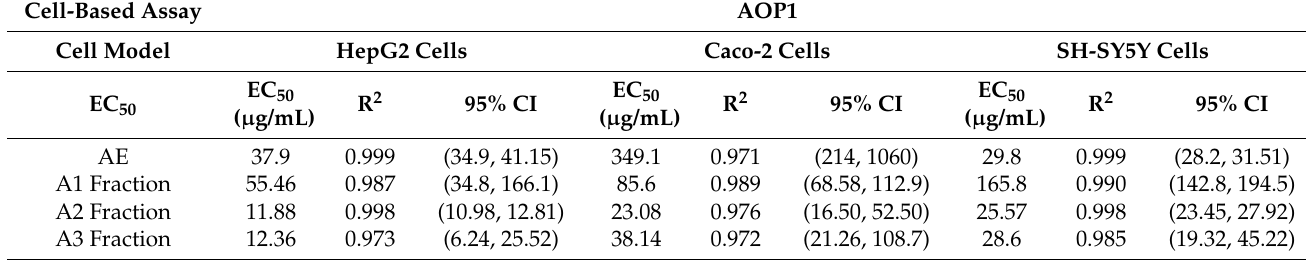
Table 1. EC 50 values for aronia extract and its phenolic fractions assessed with AOP1 bioassay on three cell models. EC 50 values are expressed in micrograms of product per milliliter. The 95% CIs represent asymmetrical confidence intervals, and R 2 indicates the determination coefficient of the sigmoid regression model fit. There are no statistical differences among EC 50 values which are marked with the same symbol. All other EC 50 values are statistically different ( p < 0.05).